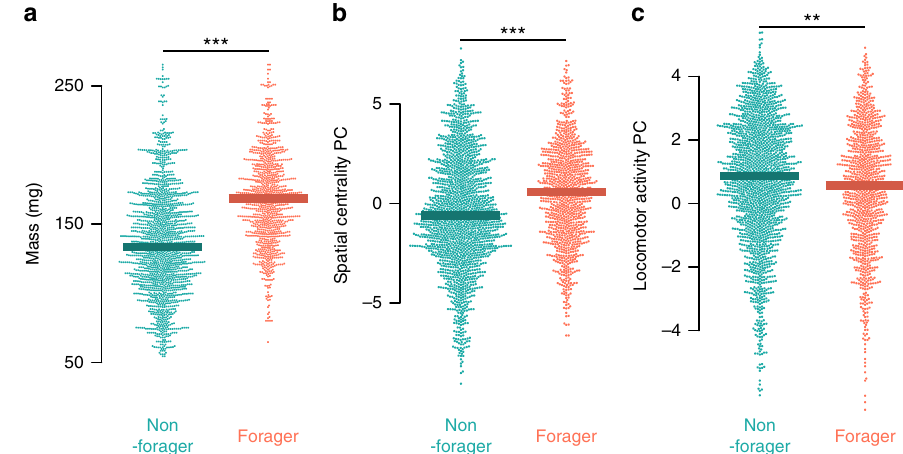
Fig. 5 Foraging is correlated with body mass and nest behavior in undisturbed colonies. Beeswarm plots of body mass (mg, a ), spatial centrality score ( b , PC1), and locomotor activity score ( c , PC2) by foraging status (forager vs. non-forager) in undisturbed colonies. Filled points show data for individual workers on unique days, and thick lines show median values for each group. ** p < 0.005, and ** p < 0.0005 in a generalized linear mixed-effects